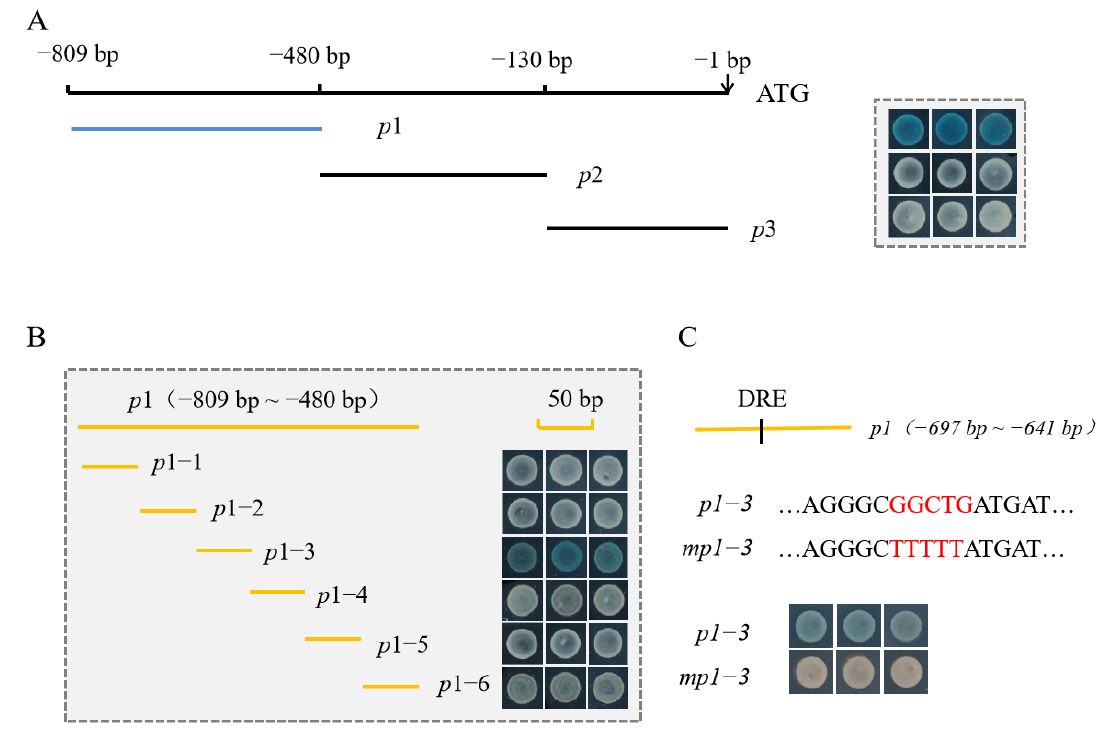
Figure 5. Sequential deletion and mutation of the VvCLH1 promoter to detect the cis -element that can interact with VvERF111. ( A , B ) A sequential deletion series and ( C ) a mutant of the VvCLH1 promoter were analyzed in yeast one-hybrid assays expressing VvERF111. The blue line represent the segment which VvERF111 binding, and the DRE motif and its mutant indicated in red.